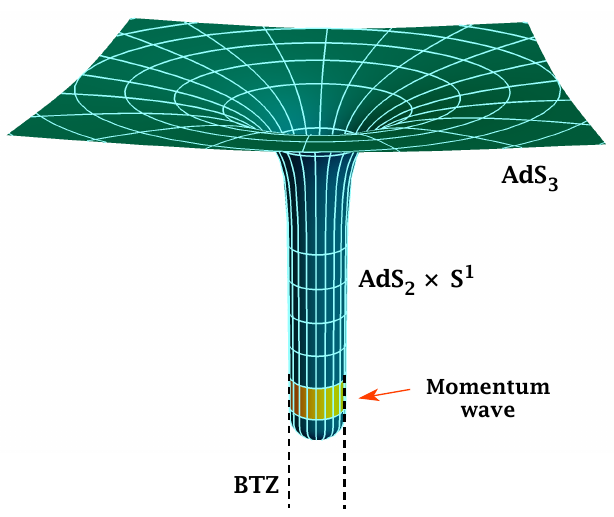
Figure 1: Schematic description of the three-dimensional geometry of